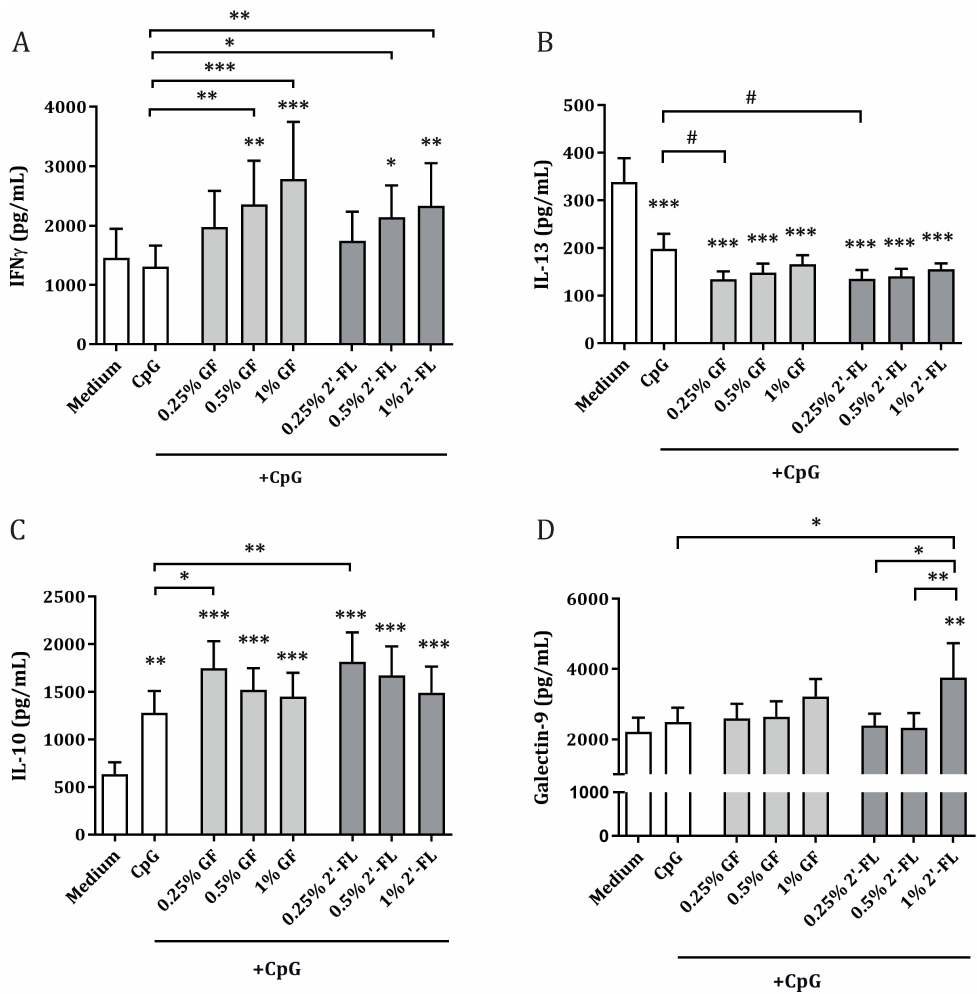
Figure 3. Cytokine and mediator secretion in IEC / PBMC co-culture. IEC were basolaterally exposed to α CD3 / CD28-activated PBMC and apically to 0.25–1% NDO (2 (cid:48) -FL or GF) in combination with CpG (Figure 1A). After 24 h incubation, IFN γ ( A ), IL-13 ( B ), IL-10 ( C ) and galectin-9 ( D ) concentrations were measured in the basolateral supernatant. Data are represented as mean ± SEM of 7–8 independent PBMC donors (# p < 0.1, * p < 0.05, ** p < 0.01, *** p <